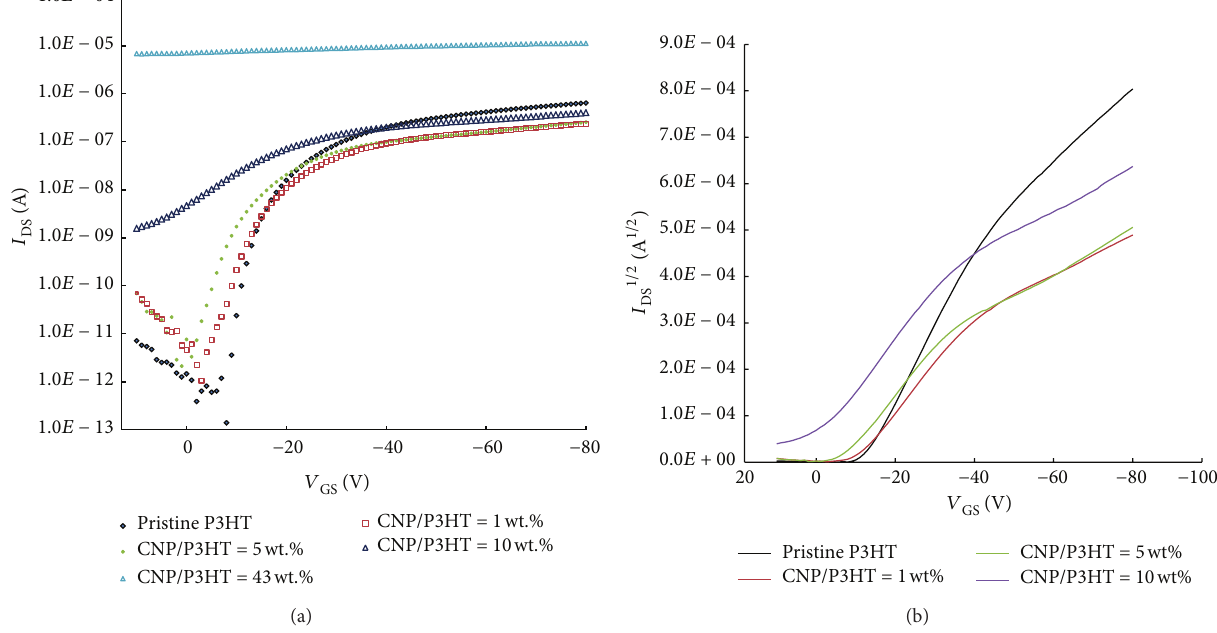
1/2 characteristics of all-inkjet-printed - 𝐼 GS DS